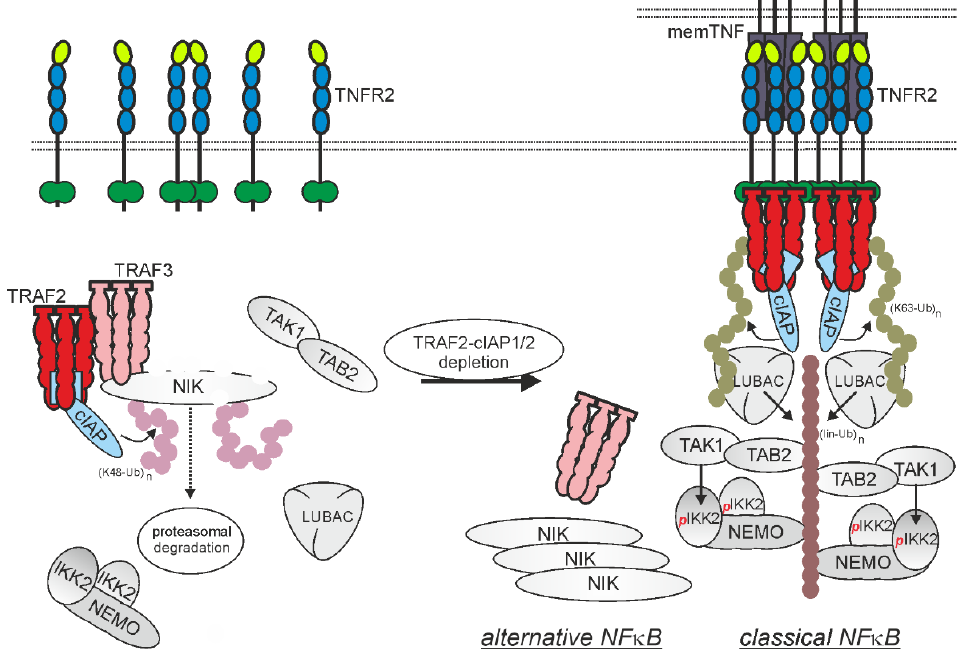
Figure 2. Membrane TNF-induced NF κ B signaling. In the absence of memTNF, TRAF3-cIAP1/2-NIK complexes interact with TRAF2-cIAP1/2 complexes in the cytoplasm resulting in cIAP1/2-mediated K48 ubiquitination of NIK and proteasomal degradation of NIK (left panel). In memTNF-stimulated cells trimeric memTNF-TNFR2 complexes recruit TRAF2-cIAP1/2 complex and thus reduces their availability for triggering NIK degradation. As a consequence, NIK accumulates and drive alternative NF κ B signaling. The trimeric memTNF-TNFR2 complexes aggregates secondarily to clusters enabling proximity of two or more TRAF2-cIAP1/2 complexes. cIAP transactivation then leads to K63-ubiquitination of TRAF2 generating docking sites for classical NF κ B signaling-stimulating kinases.